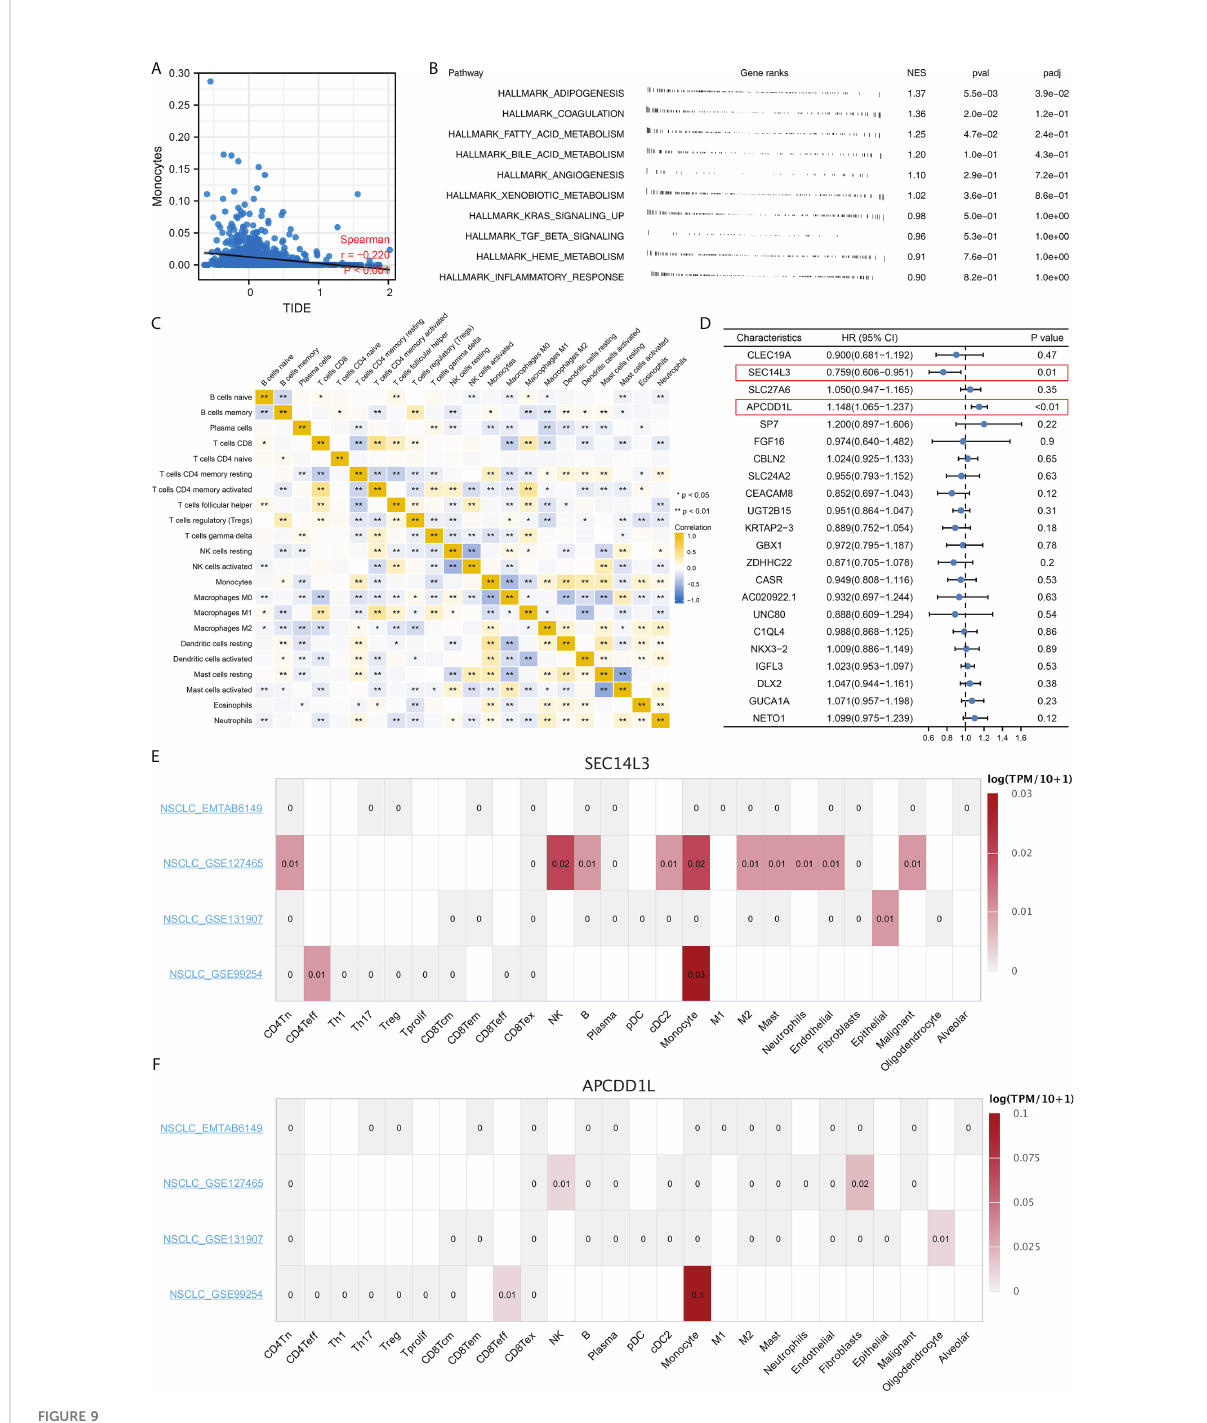
FIGURE 9 Monocytes have a potential role in affecting NSCLC immunotherapy. (A) Monocytes was negatively correlated with TIDE score; (B) Biological enrichment analysis of monocytes; (C) Correlation of quanti fi ed immune cells; (D) Among all the characteristic genes, SEC14L3 and APCDD1L were identi fi ed as prognosis-related based on the univariate Cox regression analysis; (E, F) Single cell analysis of SEC14L3 and APCDD1L based on the TISCH website. *P < 0.05; **P <